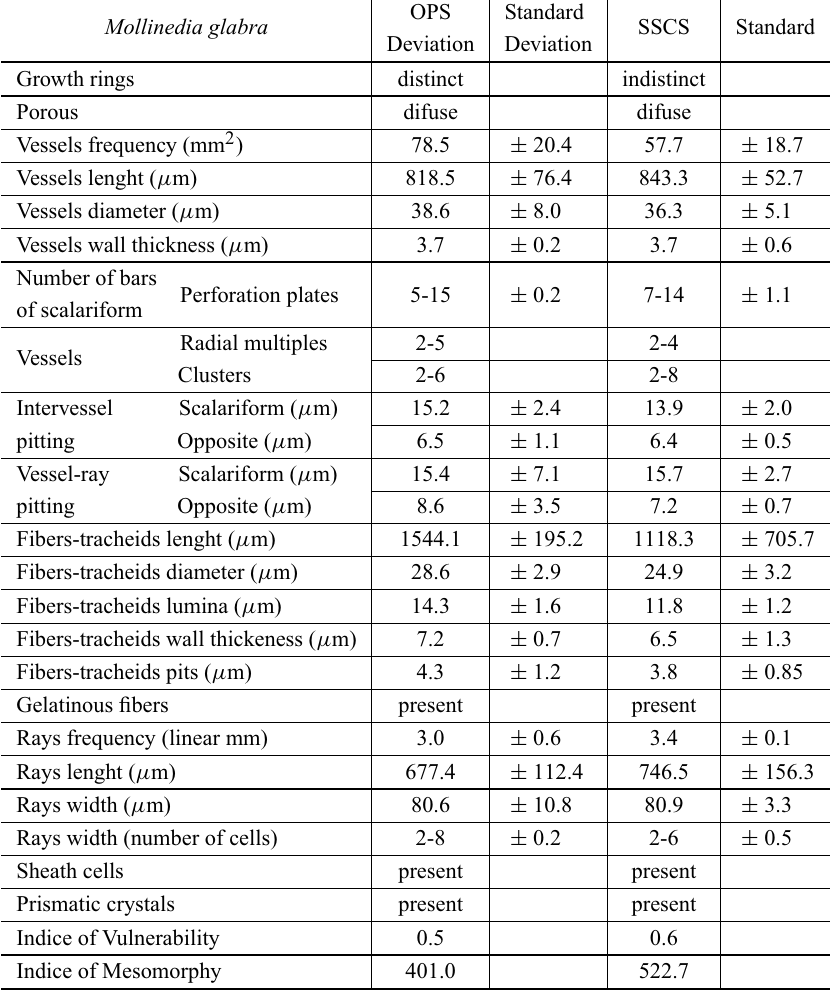
Mean and Standard Deviation of wood anatomical features of Mollinedia glabra in both plant formations (OPS = Open Palmae Shrub, SSCS = Sandy Strip Closed